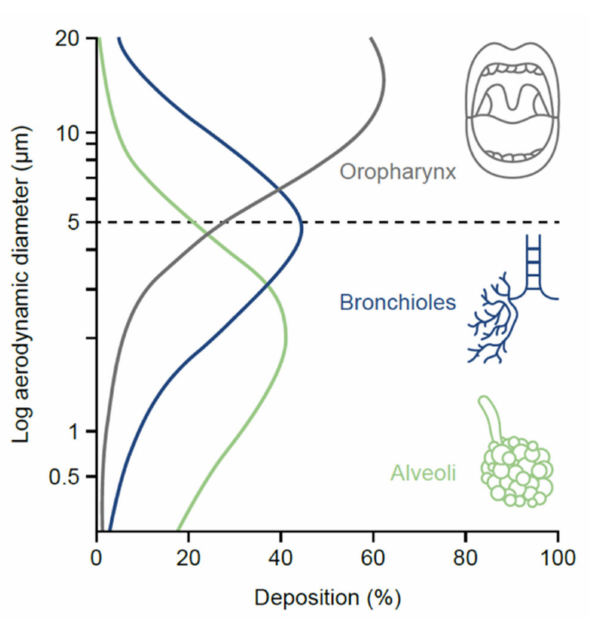
Figure 2. Relationship between aerodynamic particle diameter and drug deposition in the upper and lower